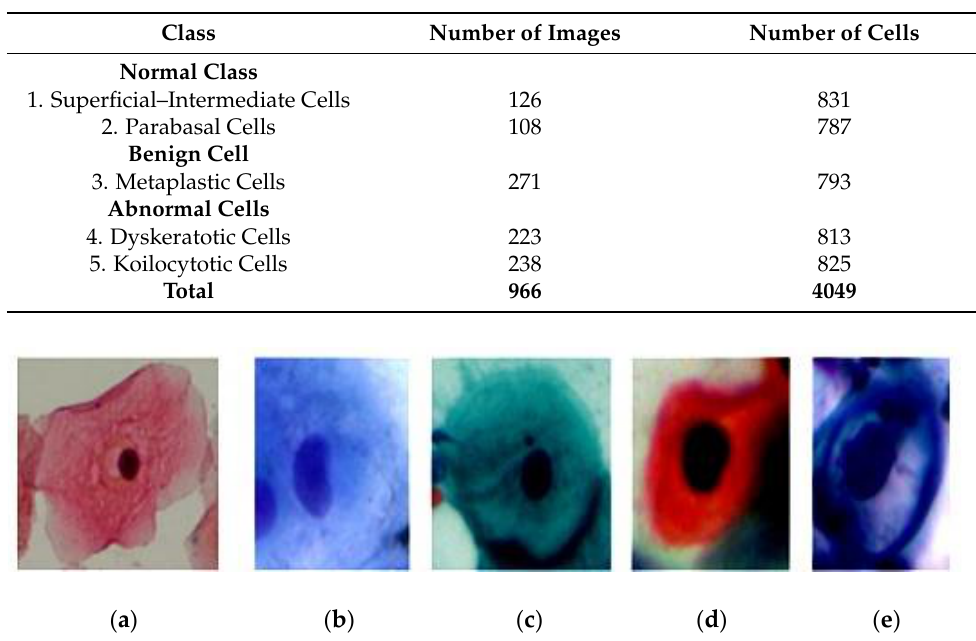
Table 1. Specification of five classes of cells obtained from the SIPaKMeD (multi-cell) dataset. Class